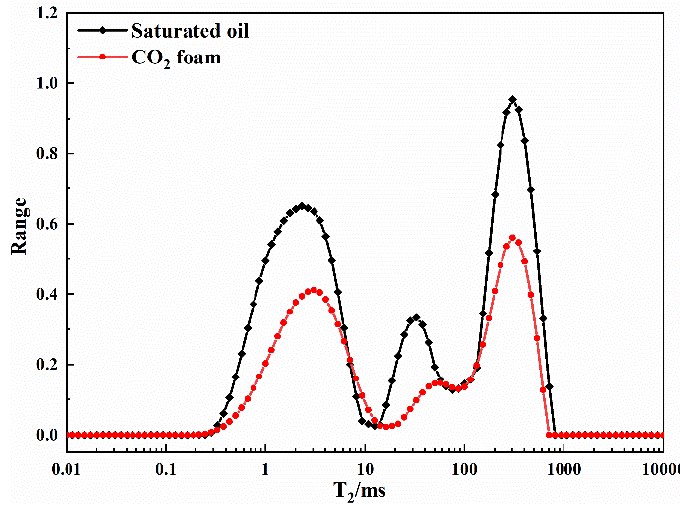
Figure 4. NMR T 2 spectra before and after injection of CO 2 foam in core No. 1.